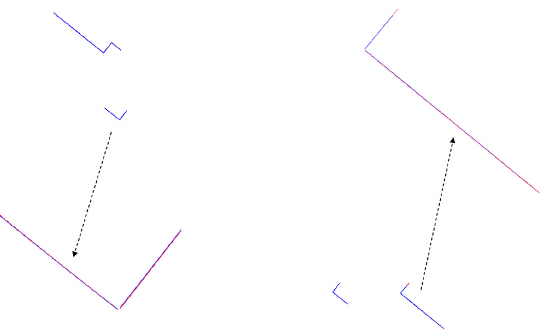
Figure 22. Two-dimensional projection line segments after registration on the X-Y plane.